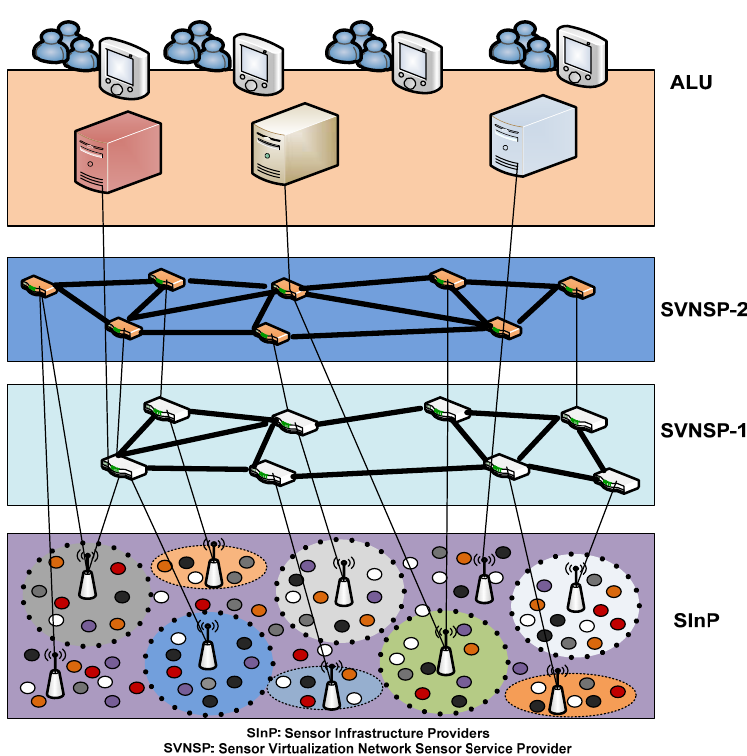
Figure 1. Business model of sensor network